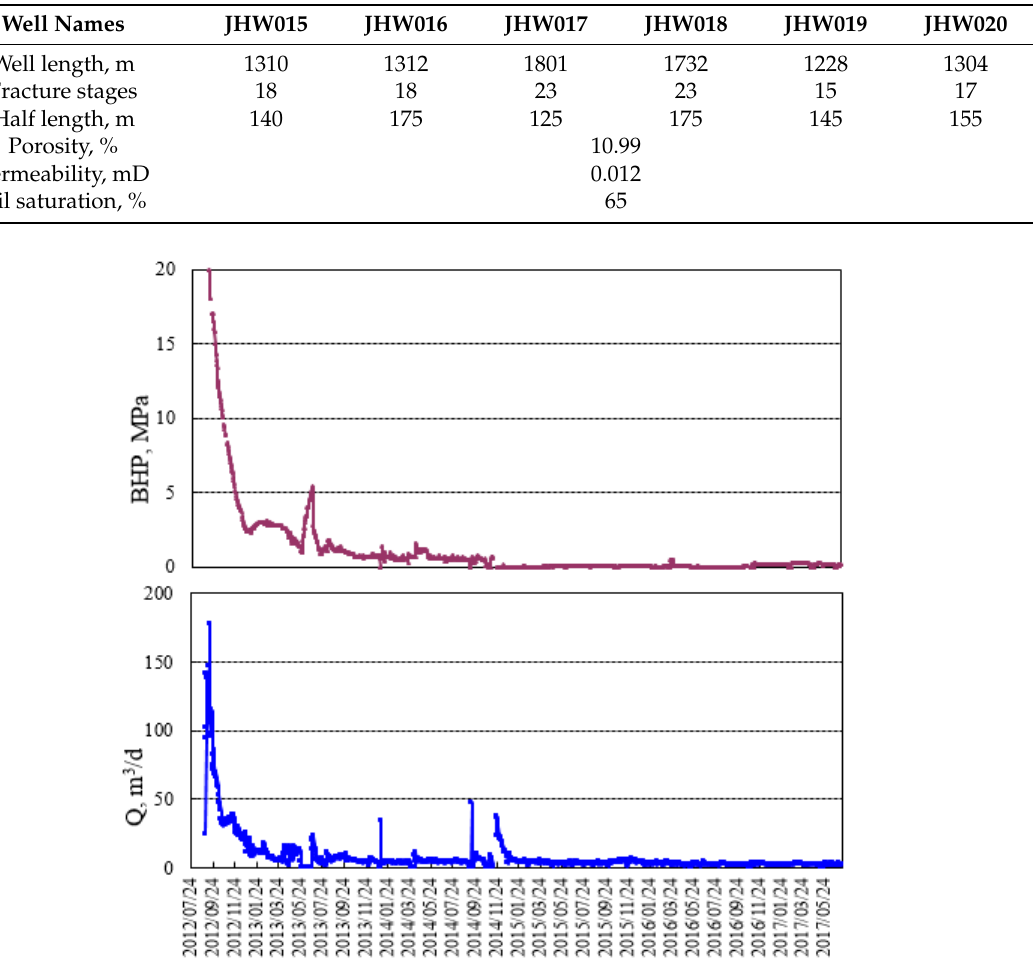
Figure 15. The scheme of the production for well JHW015.